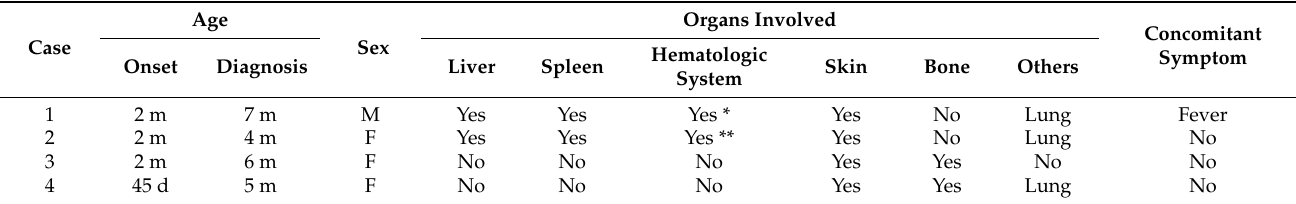
Table 1. Four MS-LCH cases with their demographic information.